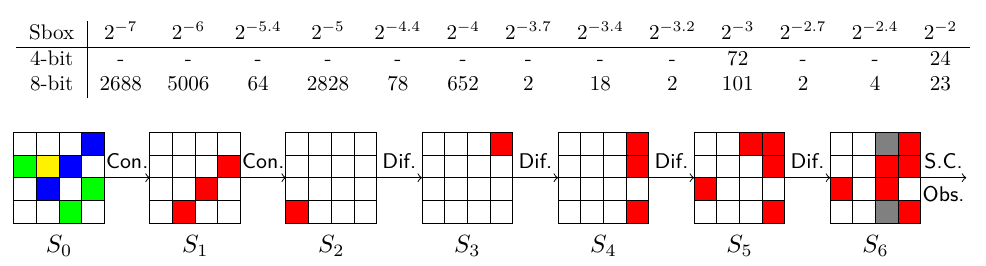
Figure 5: SKINNY differential pattern. Active cells are coloured in red. The blue and green cells in PT are chosen such that the difference will always converge to the 3 active cells in S 1 . Grey cells may or may not be